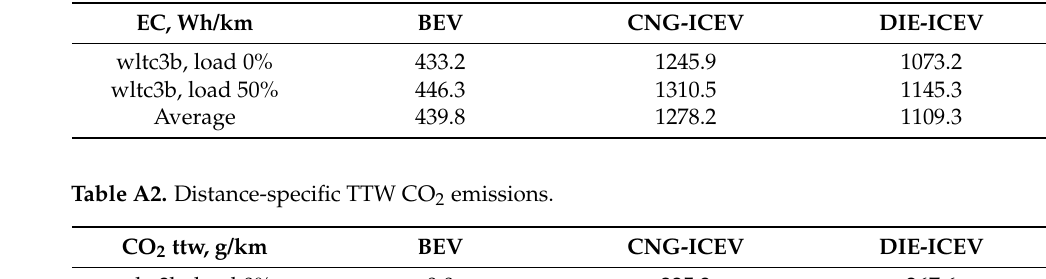
Table A1. Distance-specific energy consumption.